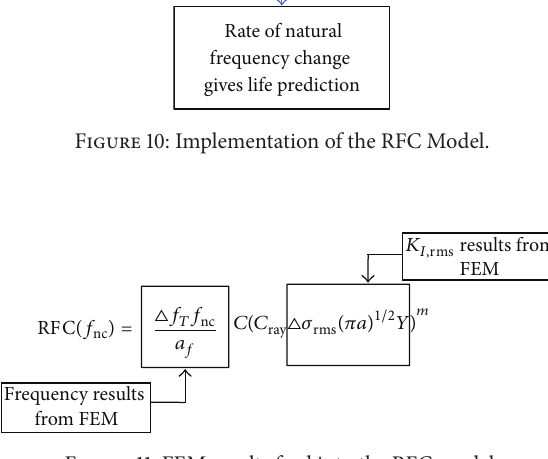
Figure 11: FEM results feed into the RFC